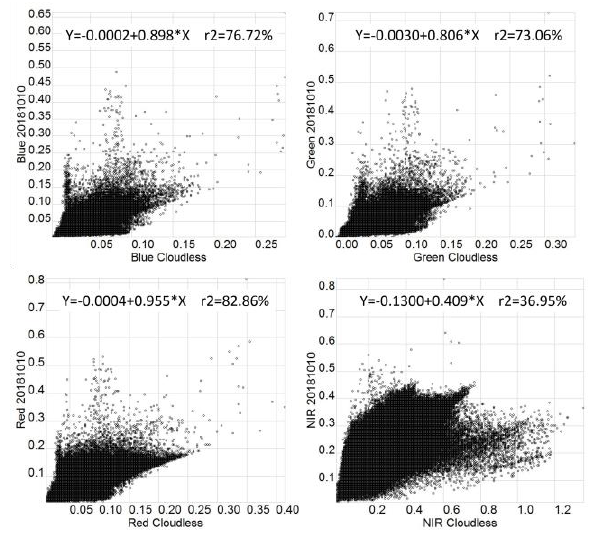
Figure 16. Scatterplots of reflectance values, along the 20 km2 sample, among the cloudless image and the reference Sentinel-2 image. From top left, to bottom right image: Blue, Green, Red, and NIR band In this case, correlation among bands is considerably higher.